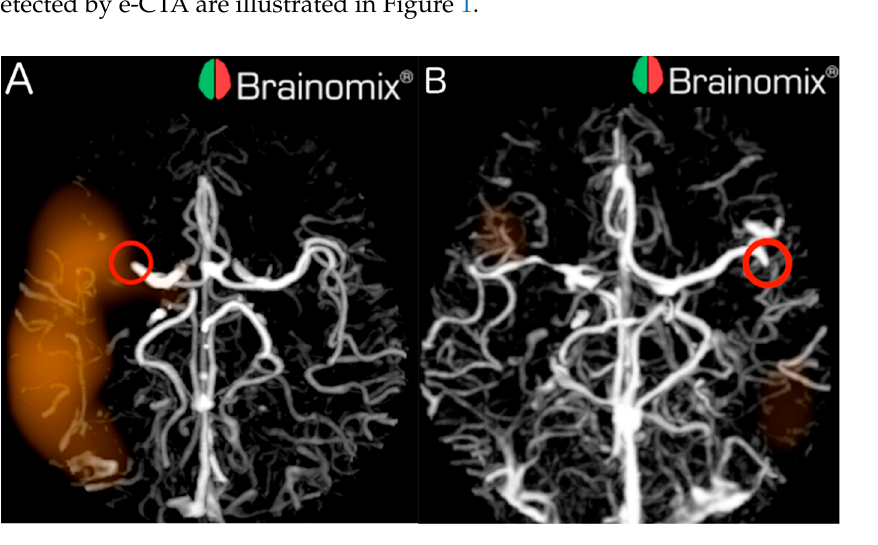
Figure 1. CTAs of stroke patients with LVOs correctly detected by e-CTA. ( A ) e-CTA detected proximal LVO of the right MCA-M1 (red circle); ( B ) e-CTA detected distal LVO of the left MCA-M2 (red